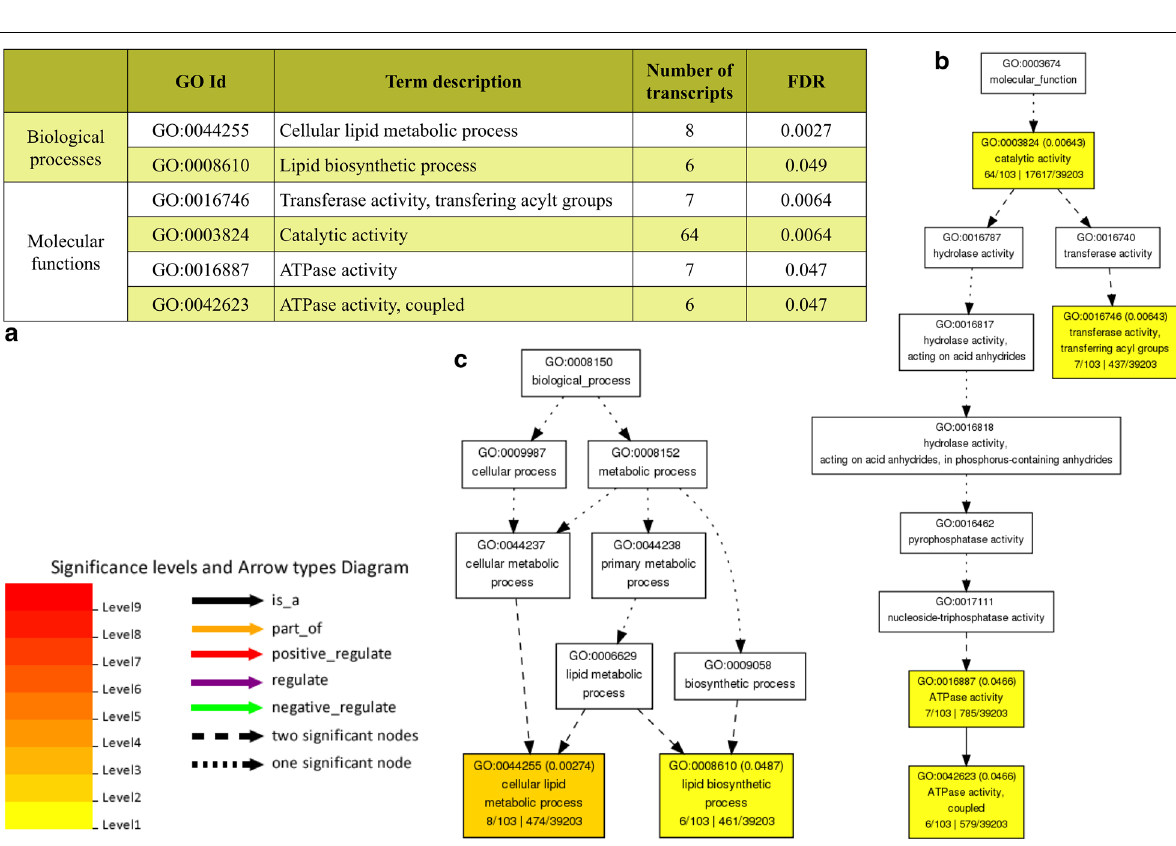
Fig. 6 Pathways enrichment analysis of the miRNA targets from the 15 novel miRNAs predicted in this study. a List of the differentially regulated (FDR < 0.05) GO terms; b differentially regulated pathways for biological processes; and c differentially regulated pathways for molecular function (FDR < 0.05) analysed by agriGO online